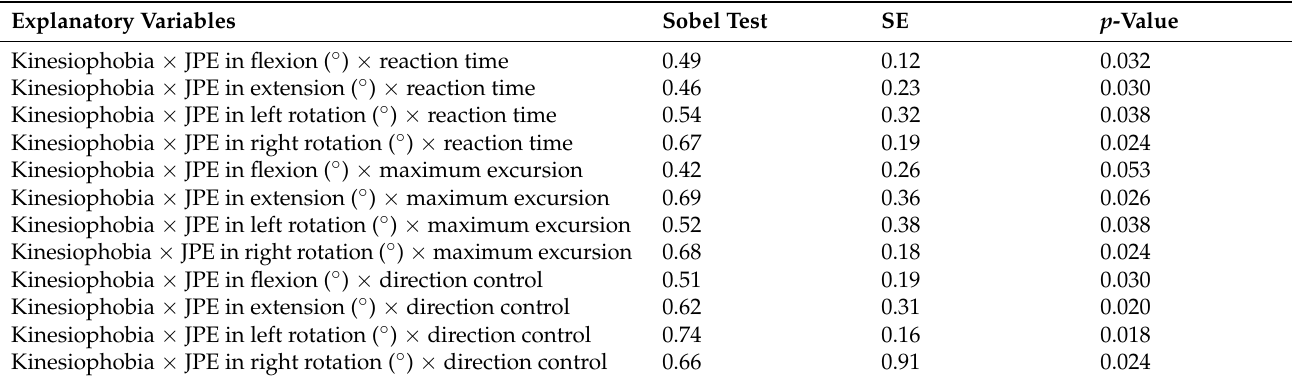
Table 5. Sobel test for indirect effect for statistical